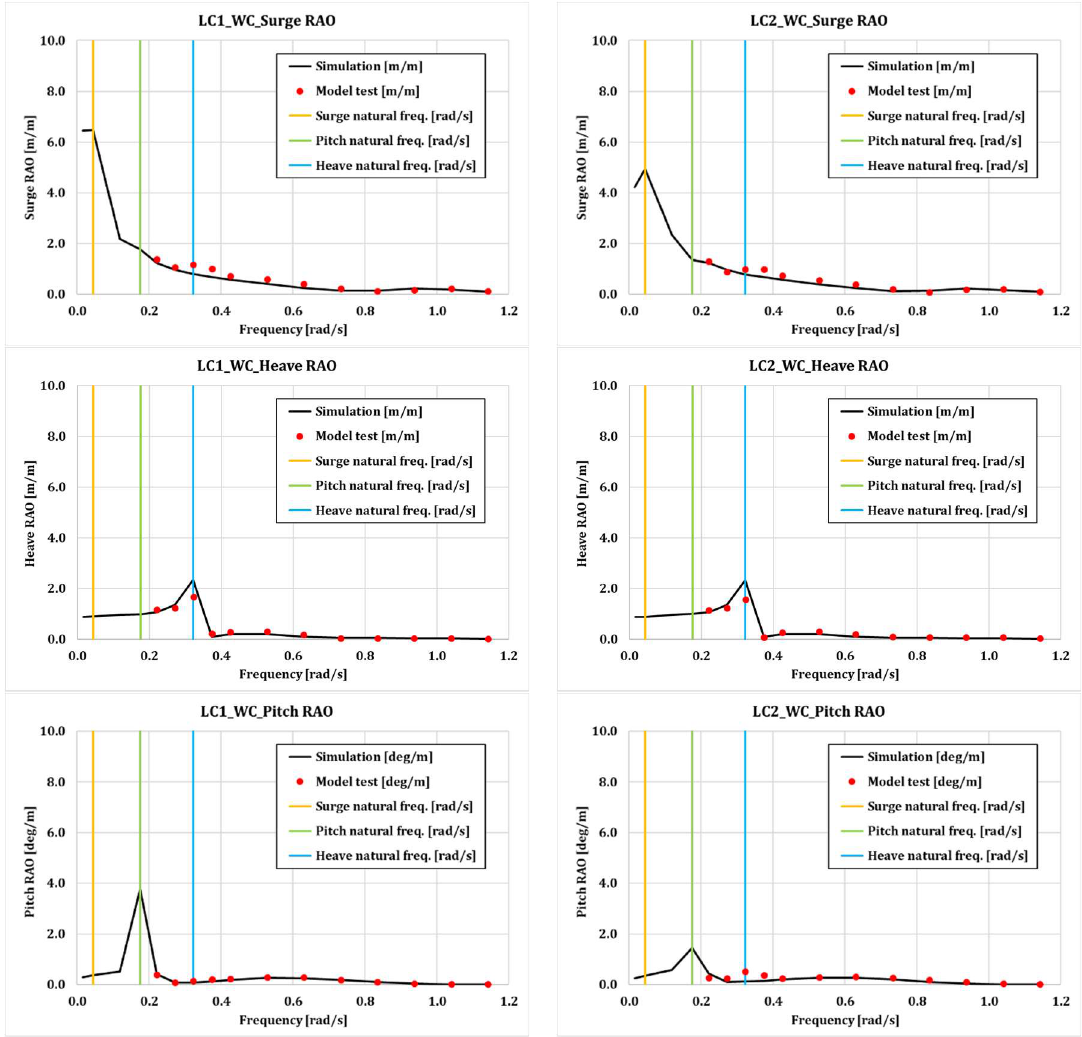
Figure 14. RAO for the surge, heave, and pitch motions of a platform with current.